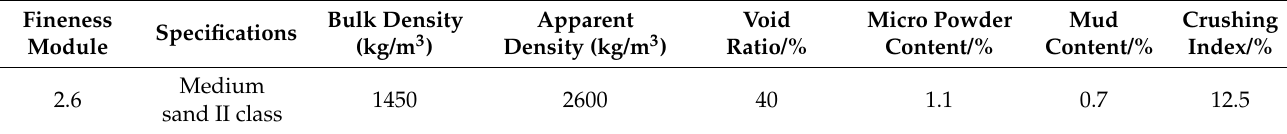
Table 3. Performance indexes of natural fine aggregate.